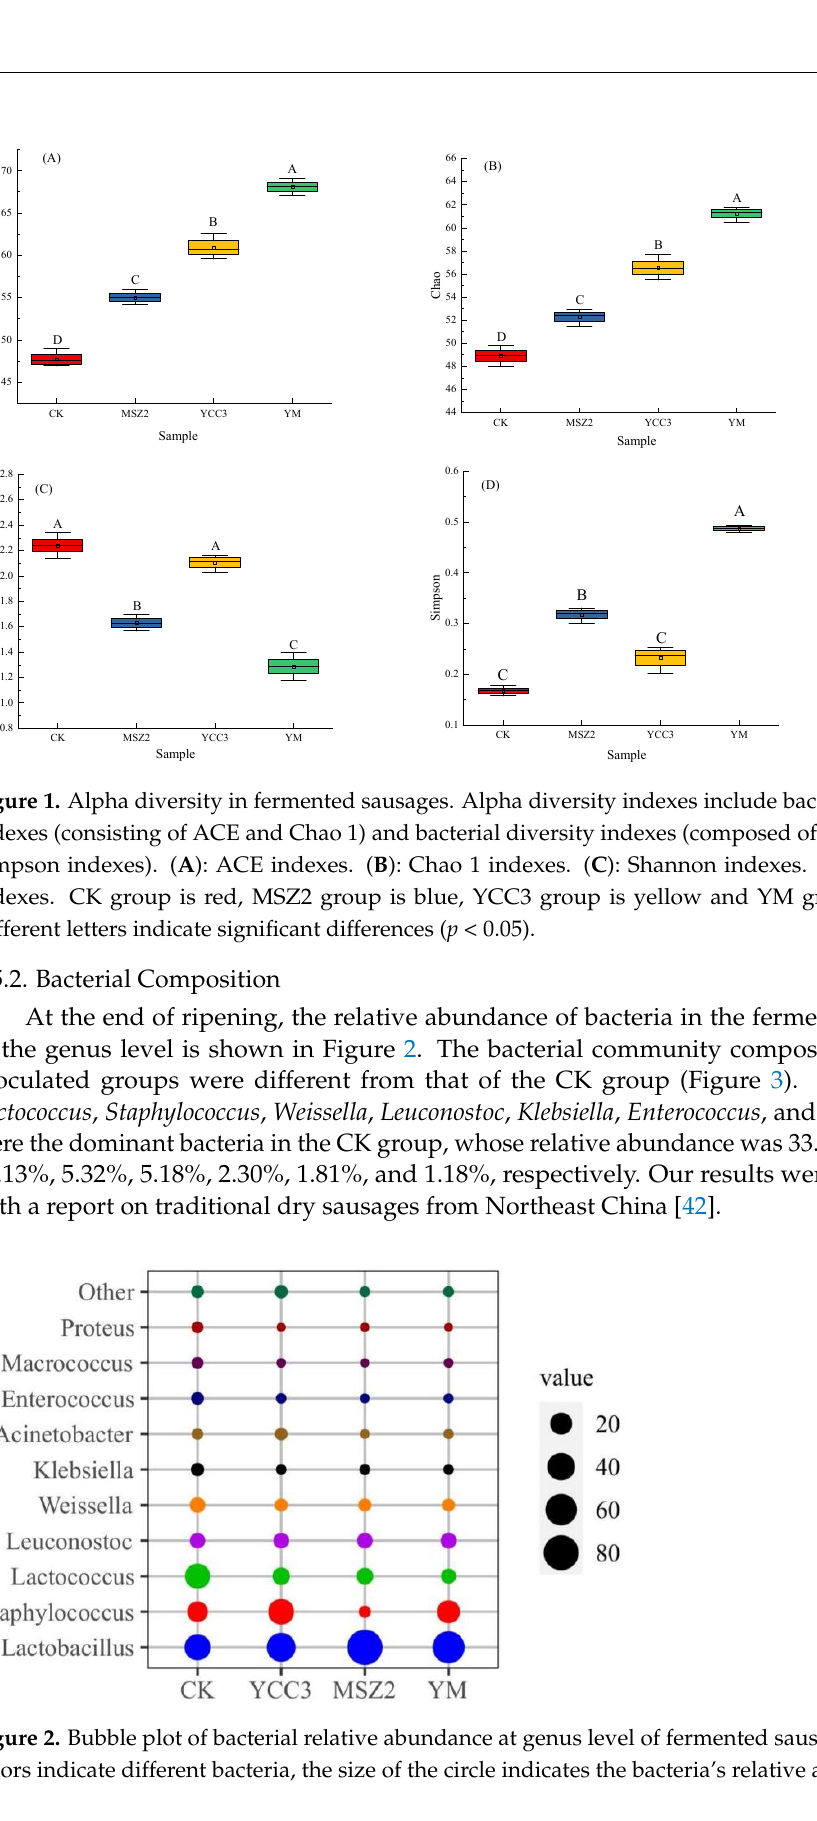
Figure 3. Bacterial community composition heatmap at genus level in fermented sausage. The colors correspond to normalized mean levels from low (green) to high (red).